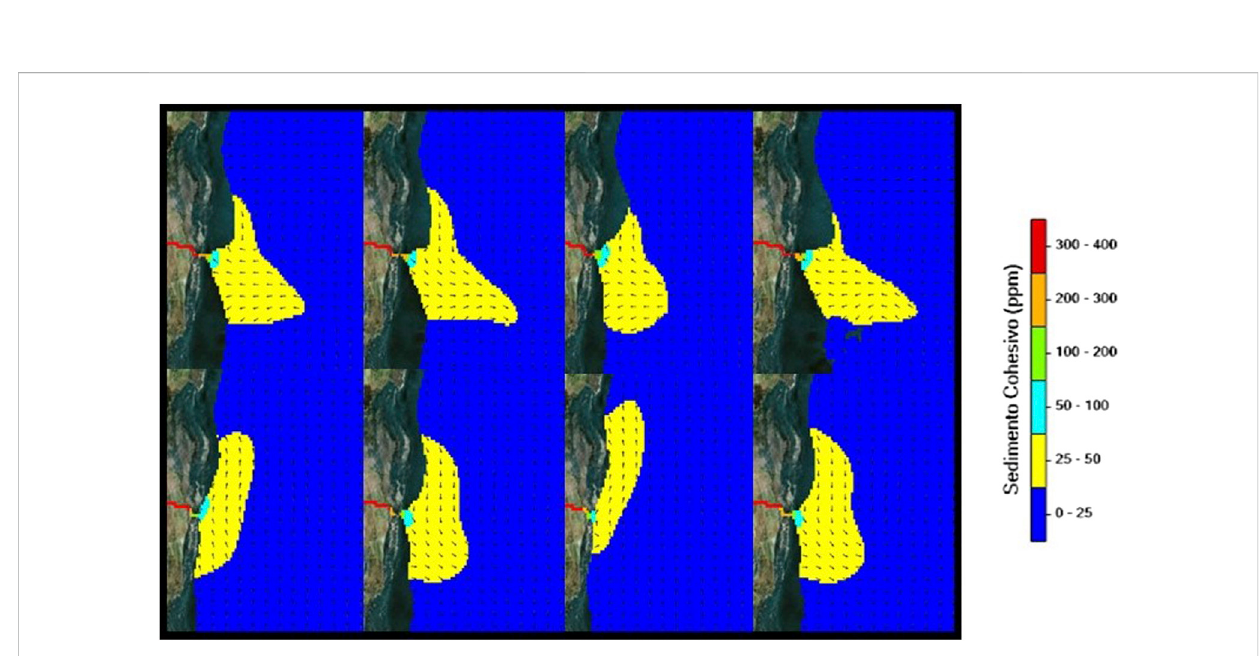
CS discharges of Irrigation network over the sea- 2019/01/03 (00 – 21